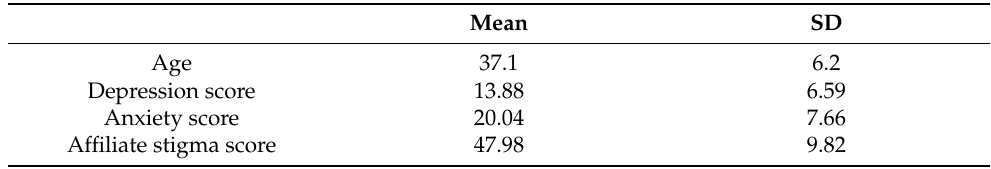
Table 1. Descriptive statistics of the